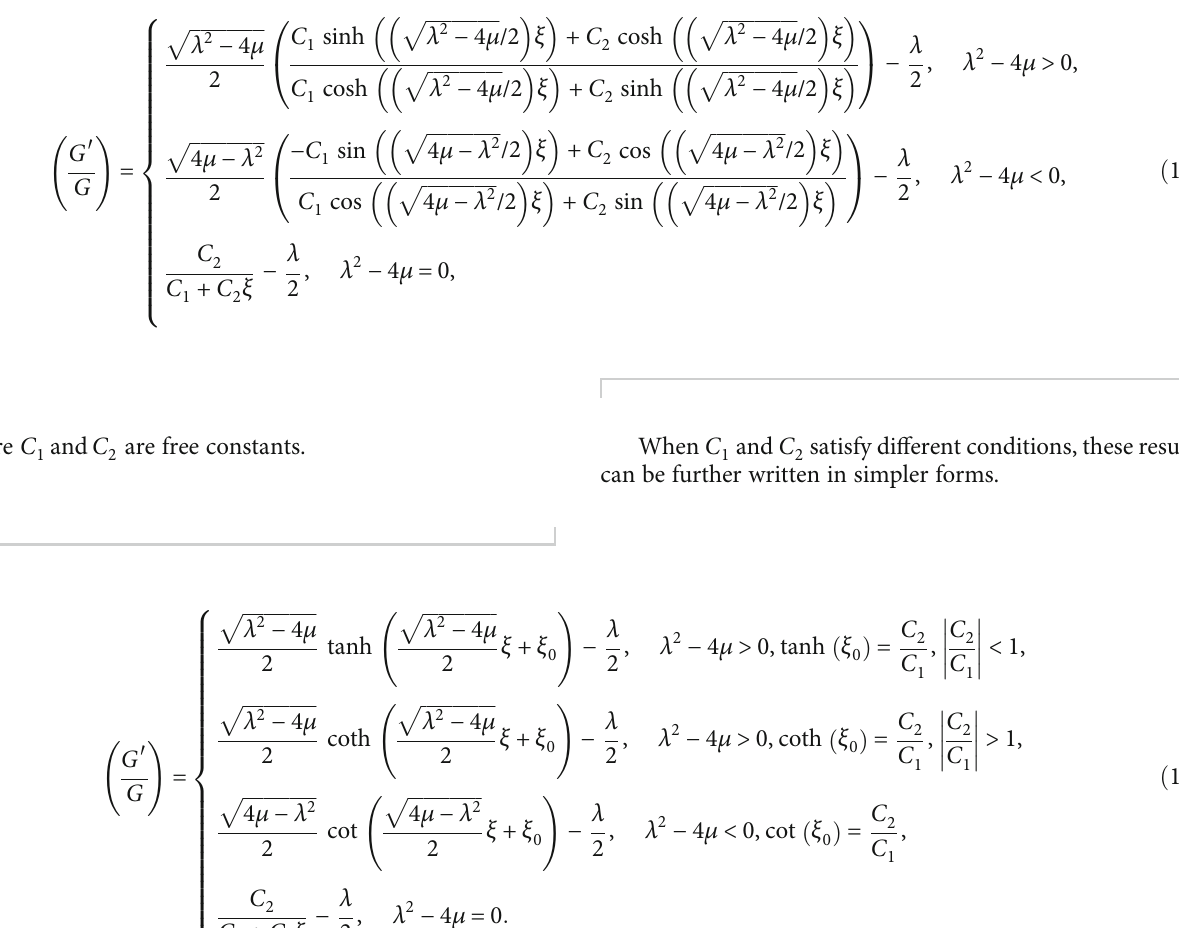
ffiffiffiffiffiffiffiffiffiffiffiffiffiffiffi p ffiffiffiffiffiffiffiffiffiffiffiffiffiffiffi λ 2 − 4 μ ffiffiffiffiffiffiffiffiffiffiffiffiffiffiffi p ffiffiffiffiffiffiffiffiffiffiffiffiffiffiffi 4 μ − λ 2